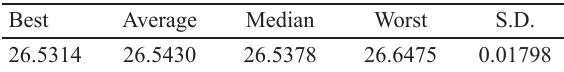
Table 1. Statistical results of the best model for tubular column design example Best Average Median Worst